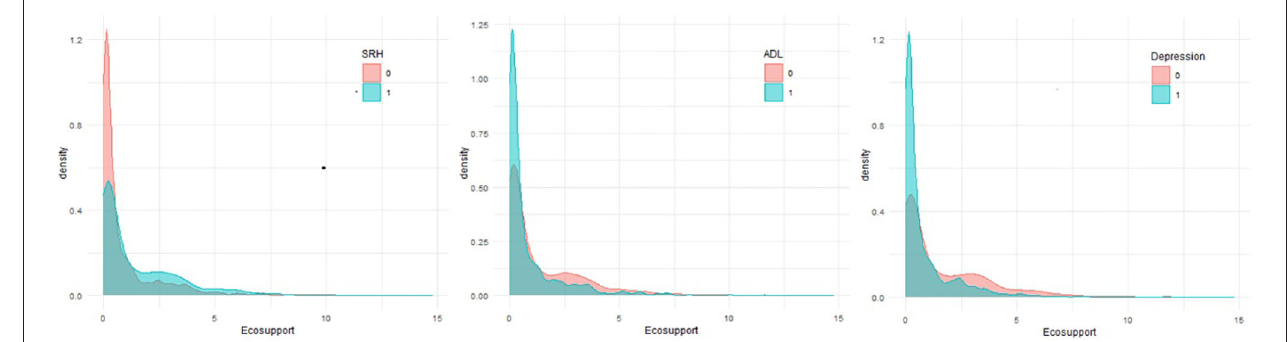
FIGURE 1 | Economic support for different health